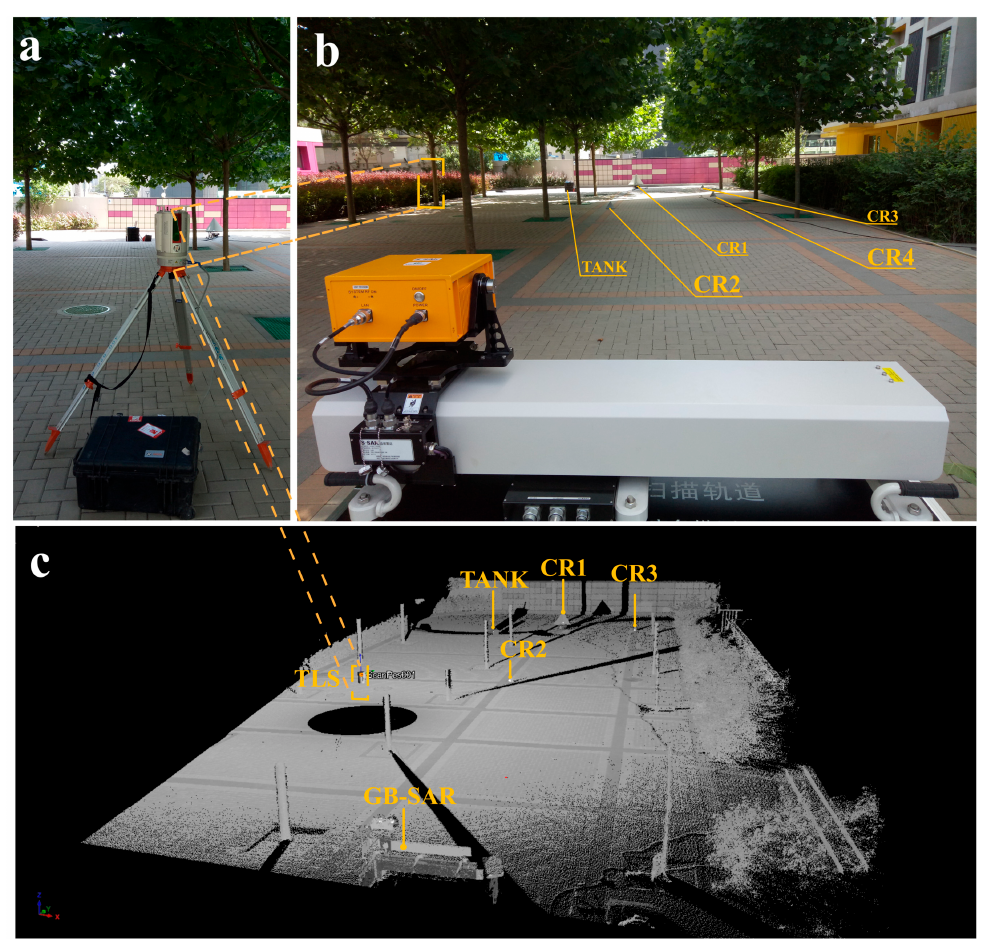
Figure 2. ( a ) Tripod-supported TLS placement; ( b ) Test site from the perspective of GB-SAR under bore-sight model; ( c ) Processed point cloud where various gray values represent various laser beam reflection intensities .